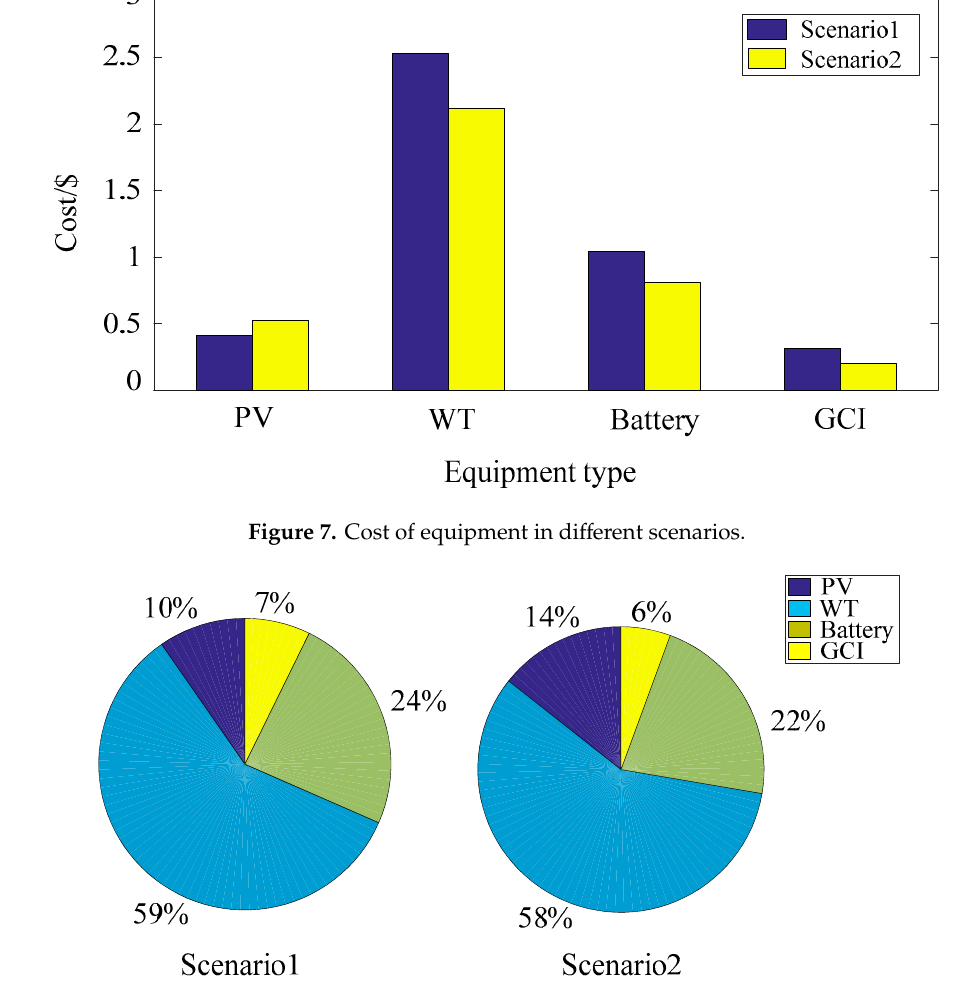
Figure 8. Cost distribution of each equipment.